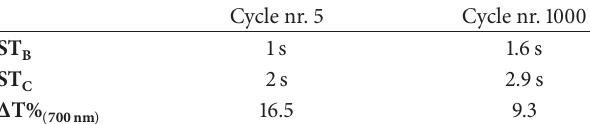
Figure 11: FTIR spectrum of V 2 O 5 film electrodeposited on ITO.